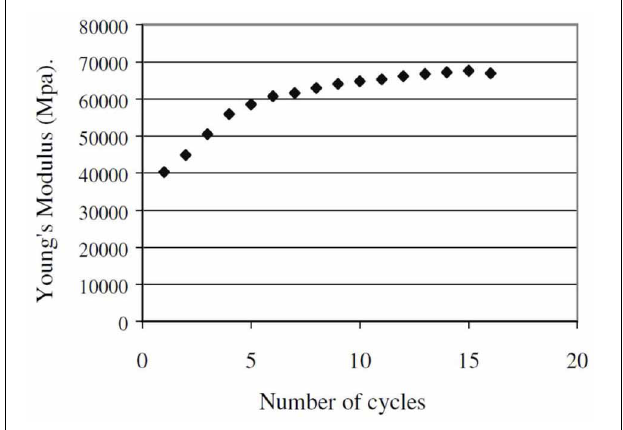
FIGURE 3 | Young’s modulus evolution of flax fibers vs. number of mechanical cycles (Baley, 2002).